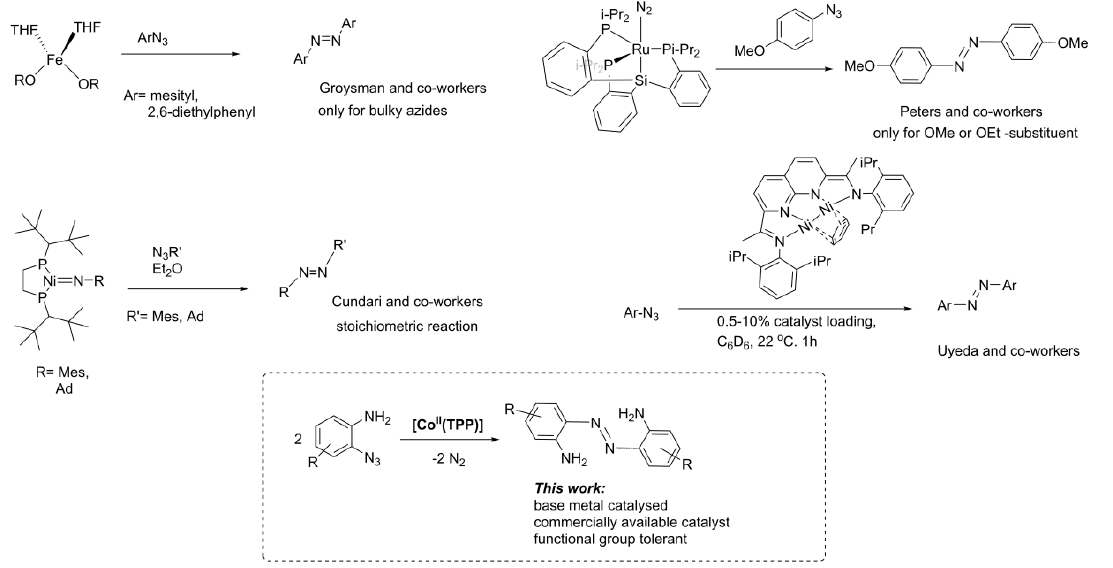
Scheme 1. Summary of reported transition metal complexes for synthesis of azobenzenes and